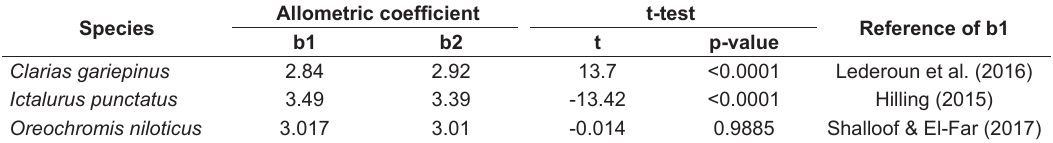
Table 2. Comparison of the allometric coefficient ( b ) estimated for non-native species between their native range ( b 1) and the recently colonized Guaraguaçu River ( b 2). Bold values denote p <